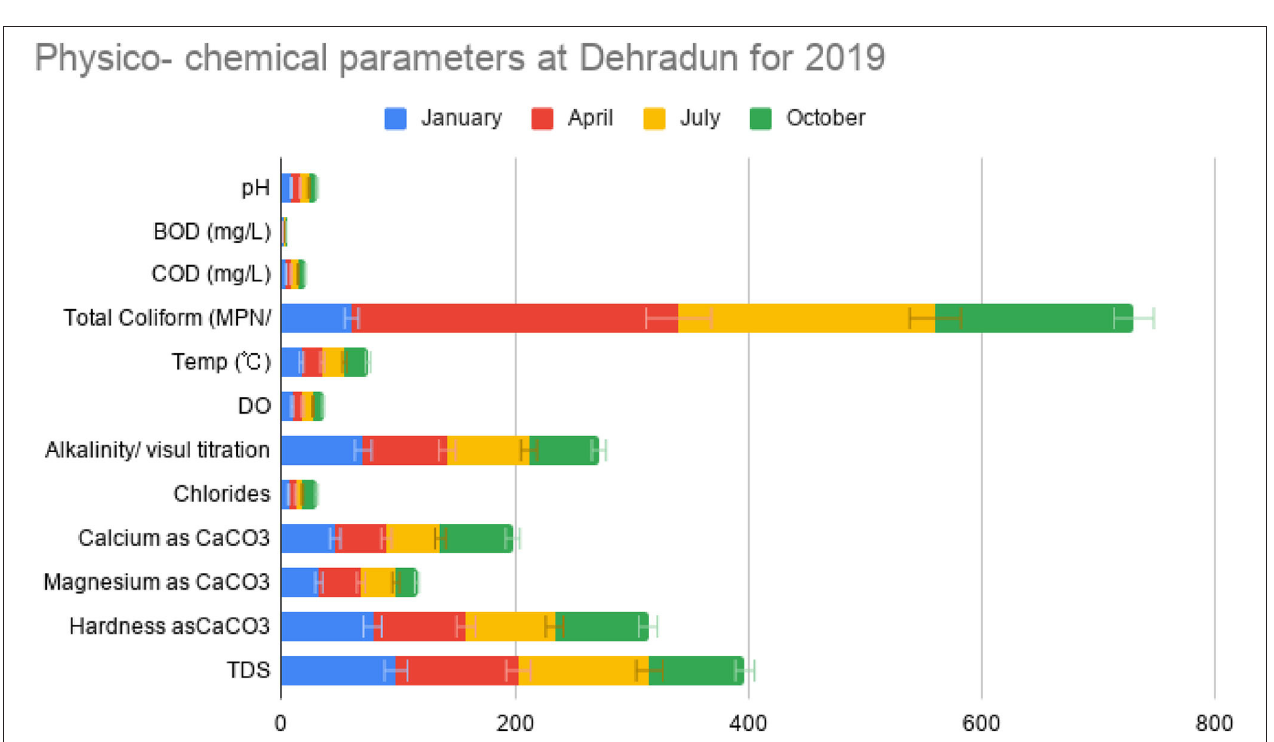
FIGURE 8 | Graphical representation of physicochemical parameters at Dehradun for 2019.